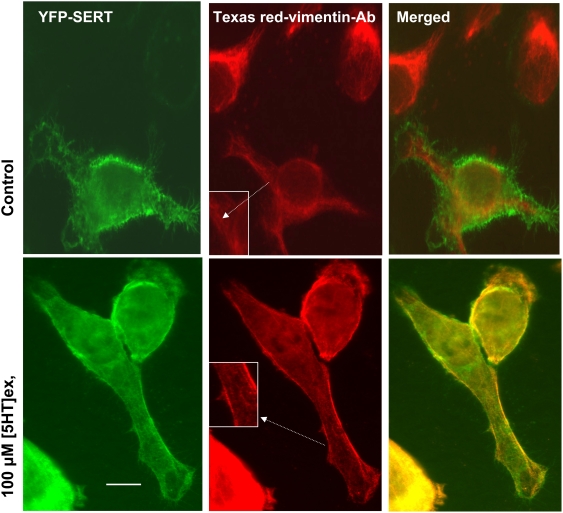
Vimentin-SERT co-localization and impact of 5HT-stimulation on their cellular distribution.CHO-YFP-SERT cells were pretreated with 5HT as indicated, labeled with vimentin monoclonal Ab, and stained with Texas Red conjugated rabbit IgG. In unstimulated cells, vimentin revealed curved filamentous structures; in 5HT-stimulated ones the vimentin filaments became straight as indicated with arrows. Cells were analyzed with a Zeiss LSM510 laser confocal microscope. To contrast the localization of SERT and vimentin, the overlaid images are presented with SERT signal pseudocolored in green. The bar (10 μm) indicates the magnification of the main figures; the insets are 2× the magnification of the main figures. Figures show representative images from at least 2 separate experiments.